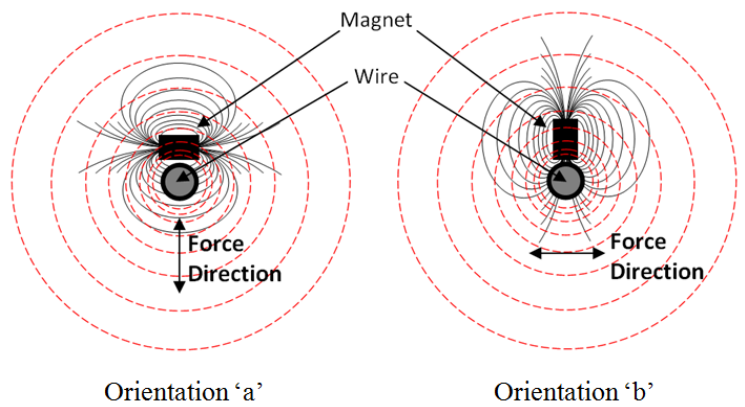
Figure 5. Magnetic fields for “ a ” and “ b ” magnet orientations.